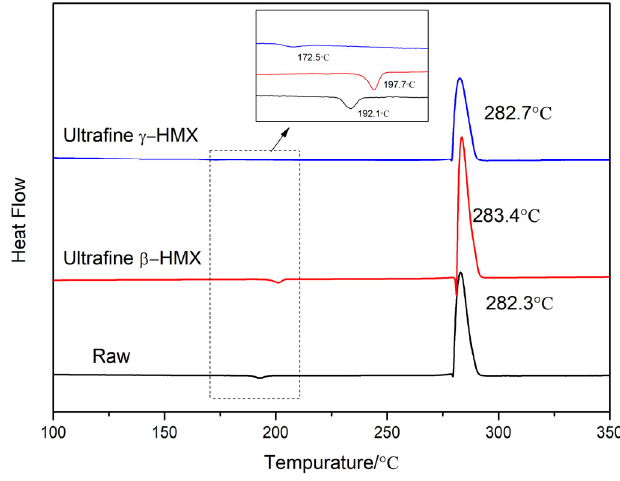
Figure 8. DSC curves of ultrafine and raw HMX. Table 2. Thermal analysis parameters of ultrafine and raw HMX.